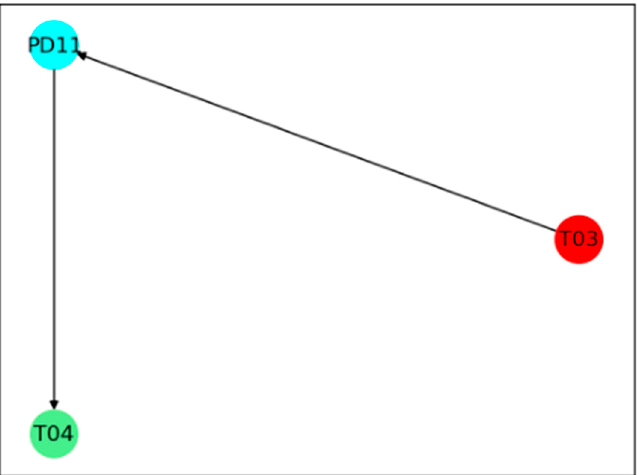
Figure 18. Fault propagation digraph in case two.